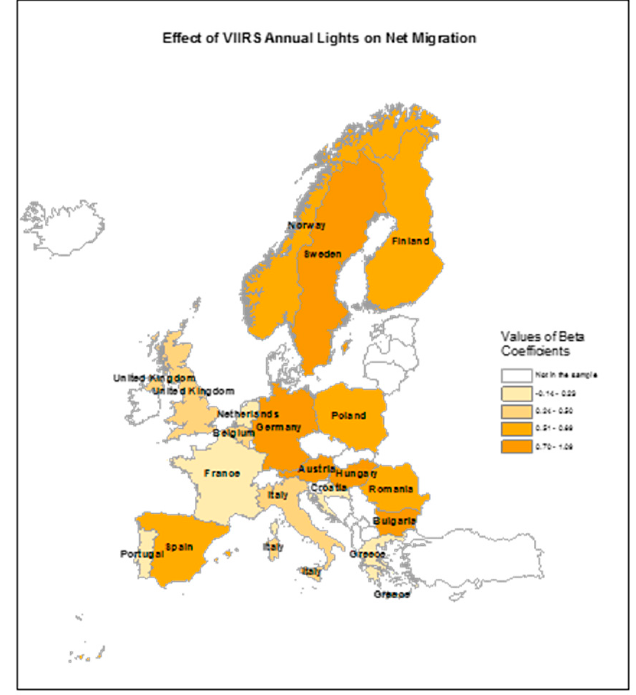
Figure 1. The e ff ect of VIIRS lights on net migration in European Union (EU) countries (2015–2016). The regression results of combined data from 18 countries with lights interaction terms also reveal the varying e ff ect of lights on migration across countries. Table 5 shows the e ff ects of interaction terms between lights and GDP, lights and population, and lights and country dummy variables. The significant coe ffi cients suggest that lights’ e ff ect on migration varies by population and GDP per capita. Hungary is used as a reference in the model to test lights’ varying e ff ects across EU countries. Results in Tables 2 and 3 suggest that the e ff ect of lights is larger in Hungary than in most other EU countries. Lights variable has a significant, positive e ff ect on migration at the base level. Most interaction terms between lights and country dummy variables are also significant, and with a negative sign, thus confirming lights’ varying e ff ects across countries and that the magnitude of its e ff ect is smaller in most countries than in Hungary. Finally, this study uses a quadratic model to test the non-linear relationship between migration and lights, and a spatial regression model to test the e ff ect of lights under the assumption of spatial autocorrelation. These results are compared to the results of the linear model. All three models (Table 6) show the significant e ff ects of lights on migration. The general model fit indicators suggest that the quadratic and spatial lag models fit the data better than the linear model. Figure 2 illustrates the quadratic relationship between the net migration size and nighttime lights values of NUTS III areas in EU countries. The spatial lag model assumes that migration population observed at one location is correlated with migration population of the neighboring areas or attributes of neighboring areas. The spatial lag model can capture the e ff ect of surrounding areas, or the migration spillover e ff ect. In such models, the spatial parameter q is estimated for the migration population of surrounding areas. The standardized spatial weight matrix, W, is the first order queen continuity weight matrix. The parameters in the spatial lag model are estimated with the maximum likelihood